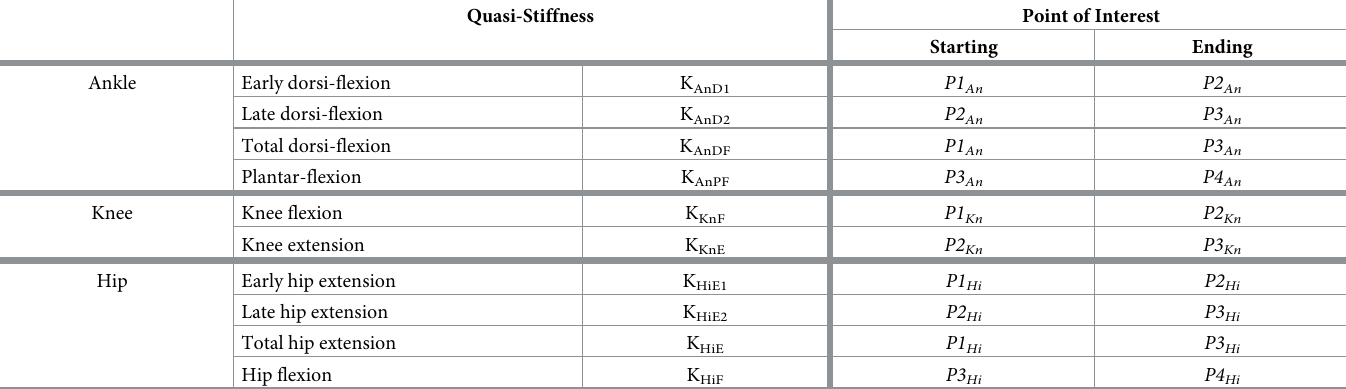
Table 1. All quasi-stiffness phases, their acronym, and the points of interest between which they were found. Quasi-Stiffness Point of Interest Starting Ending Ankle Early dorsi-flexion